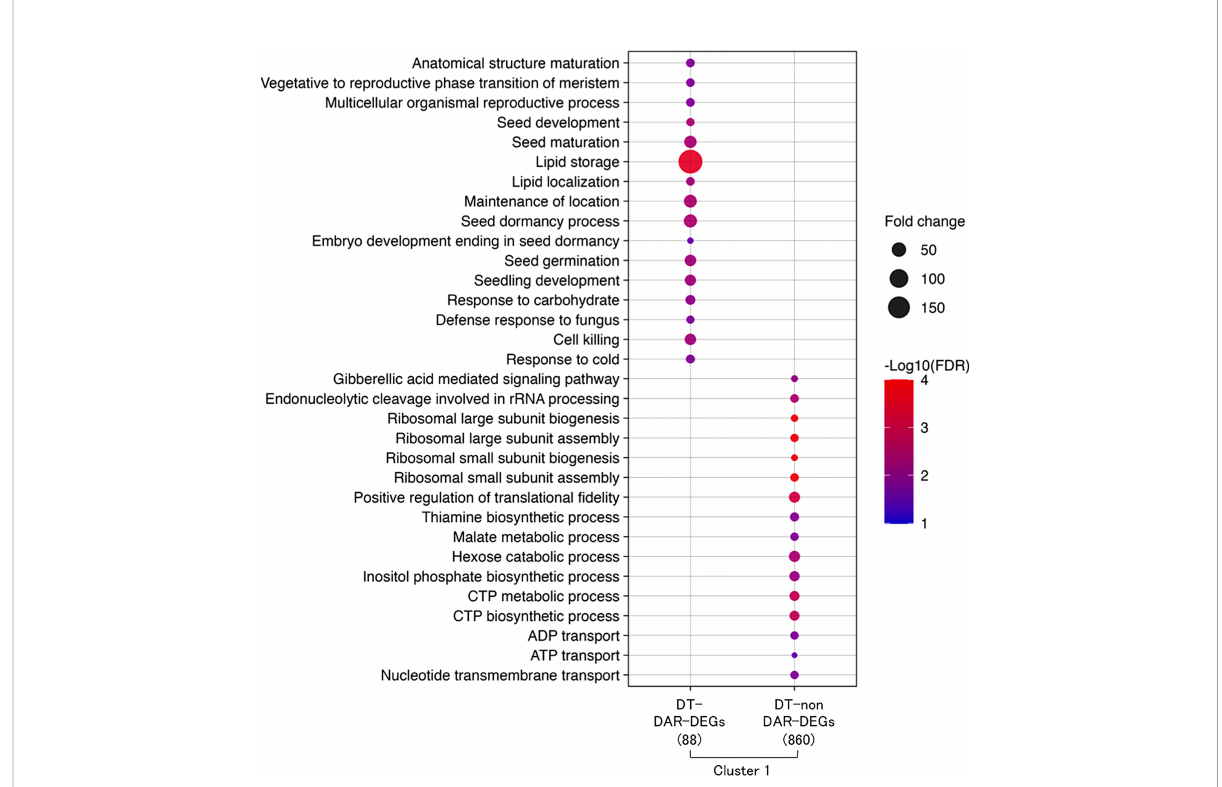
FIGURE 6 Overview of hypotheses regarding chromatin dynamics that regulates gene expressions of DT re-induction at early germination in Medicago truncatula . R1: germinated seeds with 1 mm radicles, R1P: germinated seeds with 1 mm radicles treated by PEG, R5: germinated seeds with 5 mm radicles, R5P: germinated seeds with 5 mm radicles treated by PEG. DS and DT indicate each phenotype of radicle (i.e., desiccation sensitive (DS) or tolerant